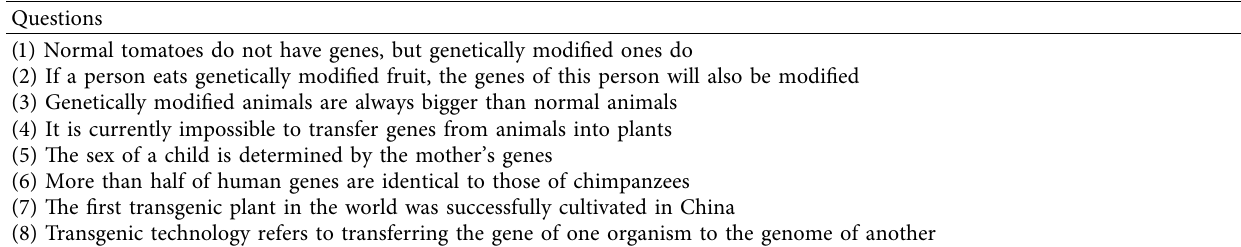
Table 2: Knowledge about gene technology.